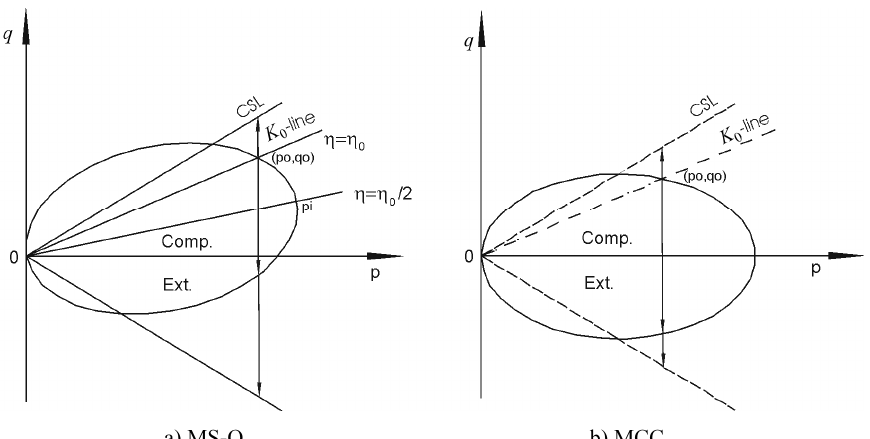
Fig. 3. Yield locus of Modified Sekiguchi-Ohta model and Modified Cam-Clay